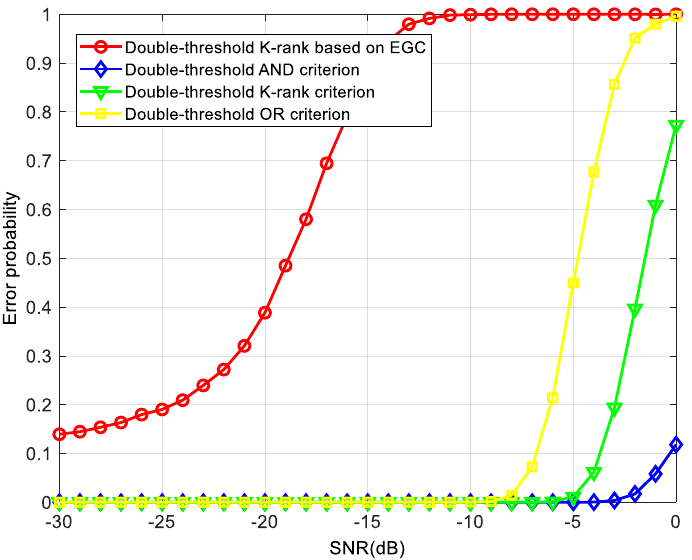
Figure 4. Detection probability of different fusion criteria (Rice factor K=5dB, noise uncertainty ρ =2).